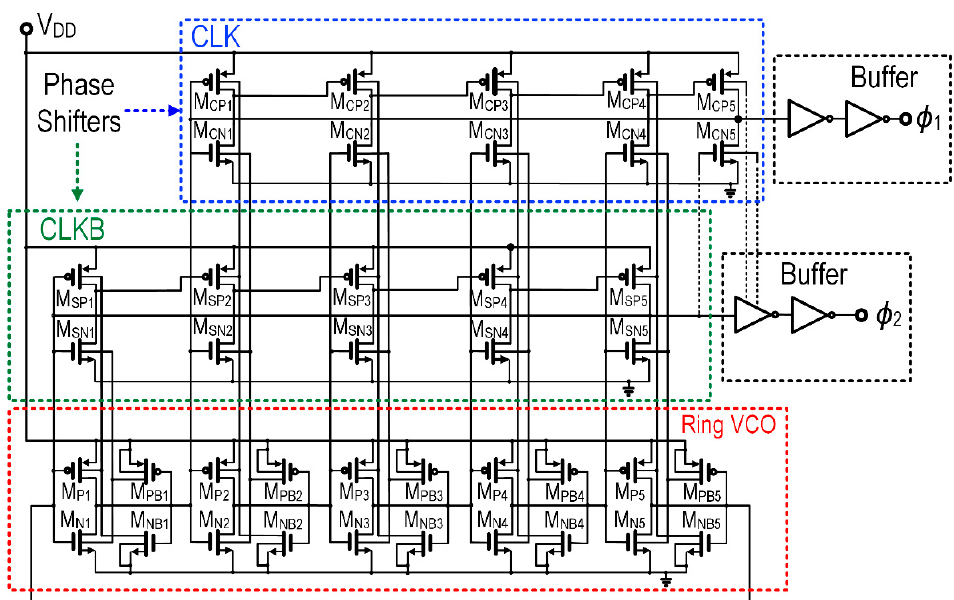
Figure 7. Complete schematic of proposed low-start-up CMOS SAB- R VCO.